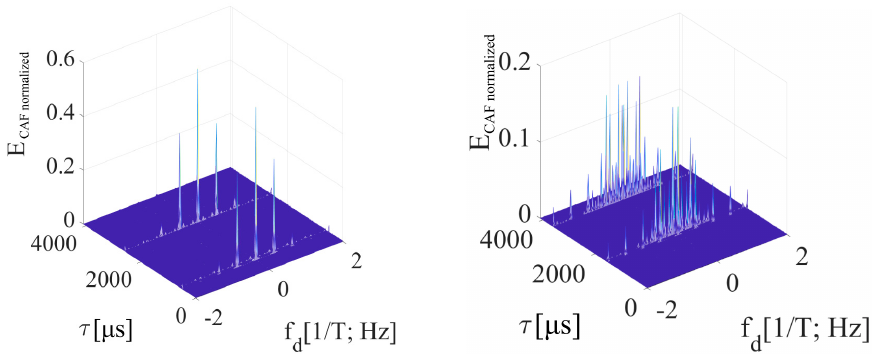
Figure 11. Result of mPCA pre-correlation processing of SC using DBZP, τ = (1 / 4) T ( left ) and τ = (3 / 4) T ( right ) .